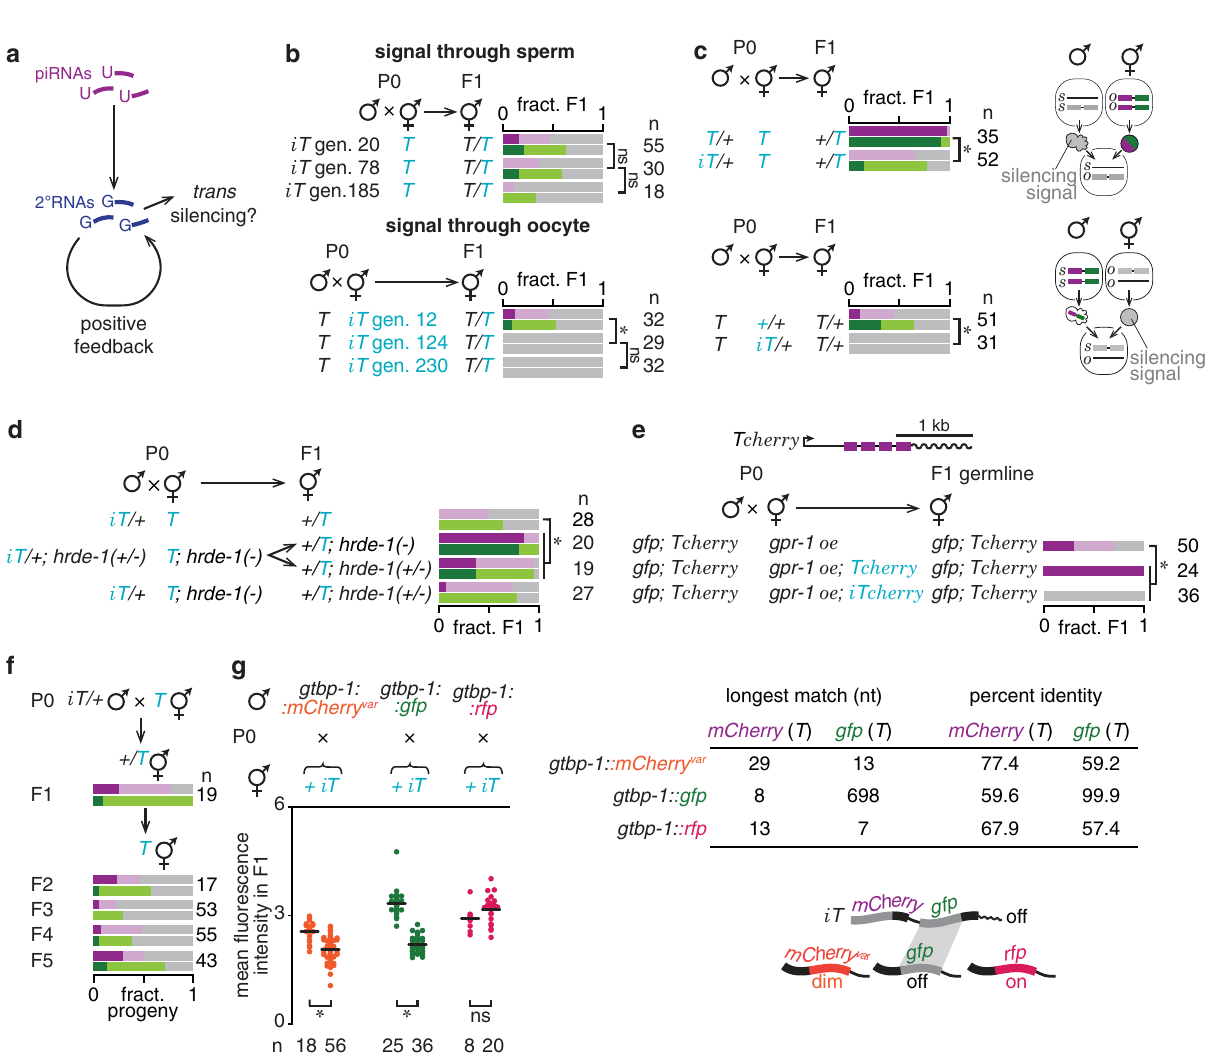
Fig. 4 Stable silencing after mating is associated with heritable silencing signals that can act in trans . a Schematic showing piRNA-mediated activation of a positive feedback for production of secondary small RNAs (2° RNAs) upon mating-induced silencing. The secondary small RNAs made at one gene could potentially act on other homologous genes ( trans silencing). b Animals expressing T were mated with iT animals that remained silenced for many generations ( iT gen. number), and cross progeny were scored. The combined data from each cross is shown in Supplementary Fig. 7a. c T animals were mated with non-transgenic or hemizygous iT animals and cross progeny that inherited only T were scored. Schematic: parental presence of iT can be suf fi cient to silence T inherited through the other gamete, indicating the inheritance of a separable silencing signal (gray fi lling). d Requirement of hrde-1 for the activity of the silencing signal was tested by parental, maternal, and/or zygotic loss of HRDE-1. e Tcherry animals silenced for more than fi ve generations upon initiation of mating-induced silencing were designated as iTcherry here. Males expressing Tcherry and Pgtbp-1::gtbp-1::gfp marker ( gfp ) were mated with iTcherry or Tcherry hermaphrodites overexpressing gpr-1 ( gpr-1 oe ). Expression of paternally inherited Tcherry in the germline was scored in cross progeny. f Silencing of T by the separable silencing signal or in trans by iT was assessed across generations. The remaining results of this cross showing the effect of trans silencing are shown in Supplementary Fig. 7c. g Males that express homologous ( gfp ) or non-homologous ( mCherry var , a synonymous mCherry variant or rfp ) sequences fused to endogenous gtbp-1 expressed ubiquitously were mated with non-transgenic or iT hermaphrodites and fl uorescence of GTBP-1::GFP, GTBP-1::mCherry var or GTBP-1::RFP was quanti fi ed in cross progeny (left). Percentage of nucleotide identity and length of the longest continuous match shared by different fl uorescent protein coding sequences in pairwise alignment using the Needleman – Wunsch algorithm (penalties for mismatch = 0.1, gap = − 1, and gap extension = − 0.2) with the mCherry or gfp sequence of T as reference are shown (right top). Schematic summary of homology-dependent trans silencing (right bottom). See Supplementary Data fi les 1 – 6 for each pairwise sequence alignment. Scoring of silencing ( b – f ) is as in Fig. 1c. Chromosomes with a dpy marker (blue font) and number of animals scored ( n ) are indicated. Asterisks indicate P < 0.05 using χ 2 test ( b – d ), Wilson ’ s estimates for proportions ( e ) or two-sided Student ’ s t -test ( g ), and ns indicates P > 0.05 using the same tests. Also see Supplementary Fig. 7 and ‘ Genetic Crosses ’ under Methods. Source data are provided as a Source Data fi restricted to the germline. Furthermore, maternal but not qualitatively distinct (e.g., different timing of small RNA paternal transmission of the silencing signal affected expres- production or different nature of small RNAs). Consistent with sion of homologous genes (Supplementary Fig. 7g). This trans silencing being homology-dependent, iT Δ established by difference in ef fi cacy and/or transmission of the silencing mating-induced silencing after deleting gfp from T did not silence signal could re fl ect differences in the intracellular environ- other gfp genes in trans (Supplementary Fig. 7f). In all cases, ment in the two gametes and/or differences in the nature or silencing (in trans or by the separable silencing signal) was